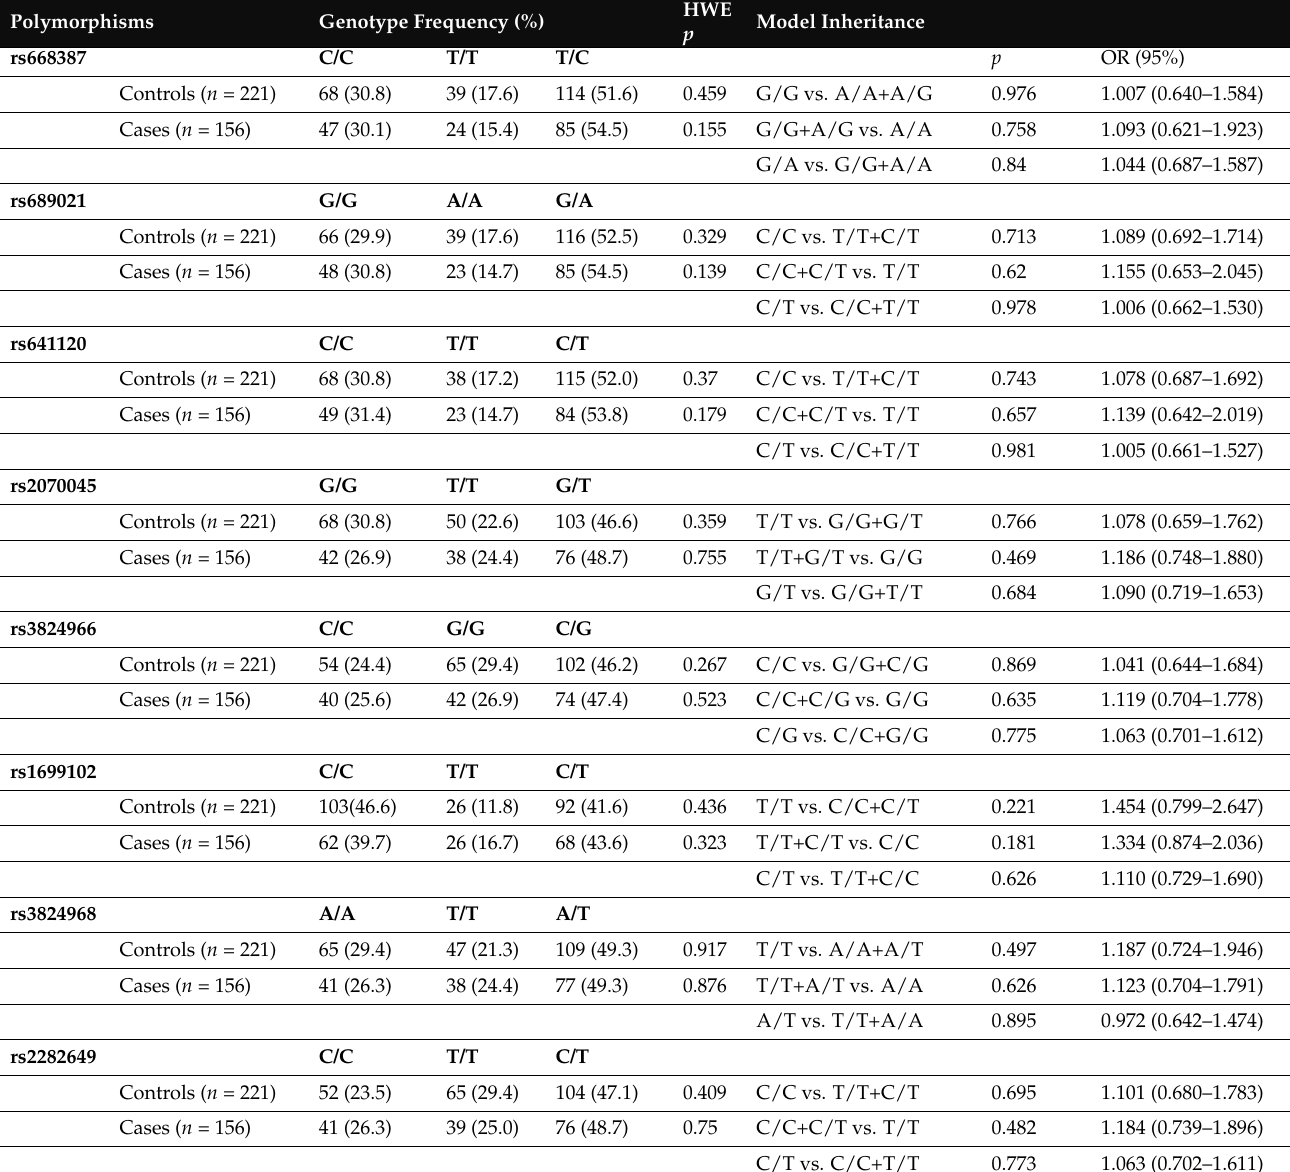
Table 2. Genotype distribution of SORL1 variants with Alzheimer’s disease in Mexican